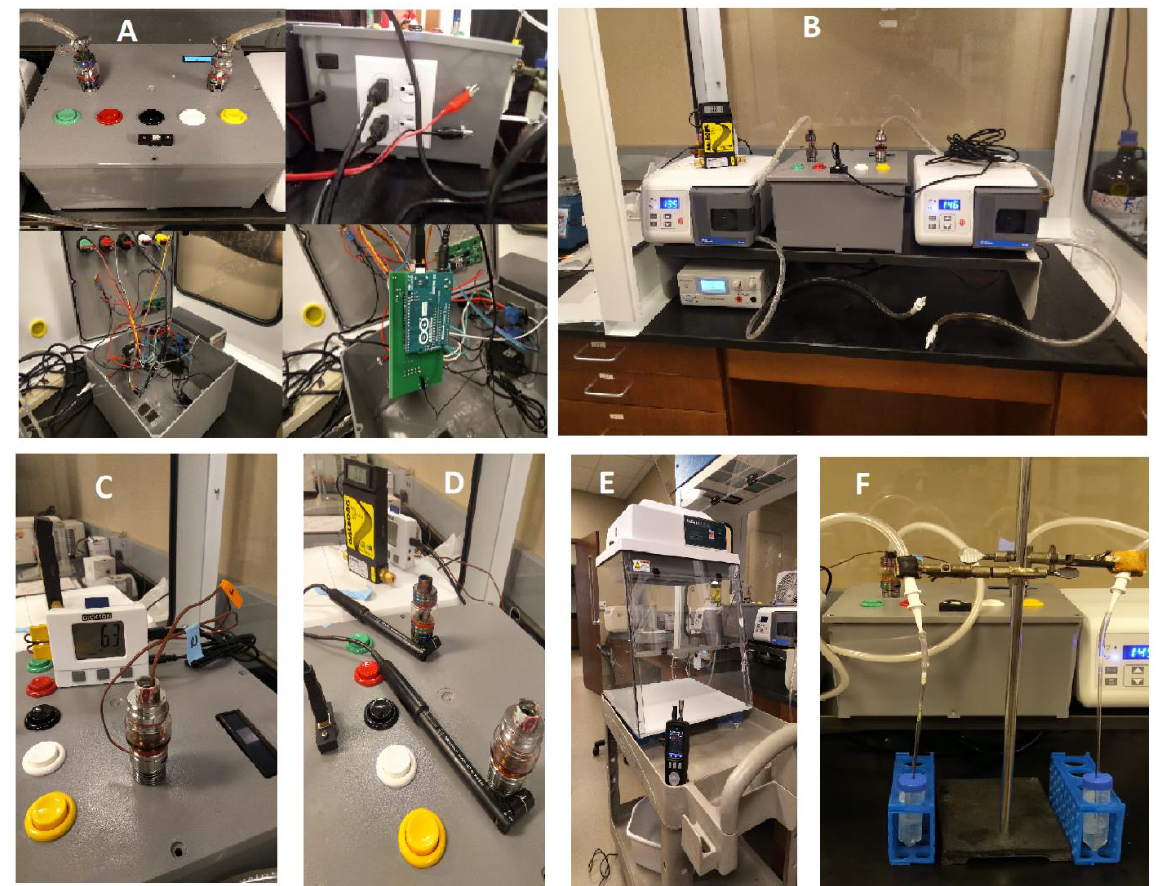
Figure 1. Programmable, dual-channel ECIG aerosol generator. ( A ) Housing for the electrical components of the pro- grammable, dual-channel ECIG aerosol generator. ( B ) ECIG aerosol generator as part of the complete system, which includes two peristaltic pumps and a DC voltage power supply. ( C ) Measurement of temperature inside the tank (orange label) and outside the tank (blue label) using K-type thermocouples. ( D ) Measurement of magnetic field using magnetic field sensors. ( E ) Measurement of particle counts (0.3, 0.5, 1.0, 2.5, 5.0 and 10 µ m size) and mass concentration of particles (2.5 and 10 µ m size). ( F ) Aerosol trapping for the measurement nicotine recovery.